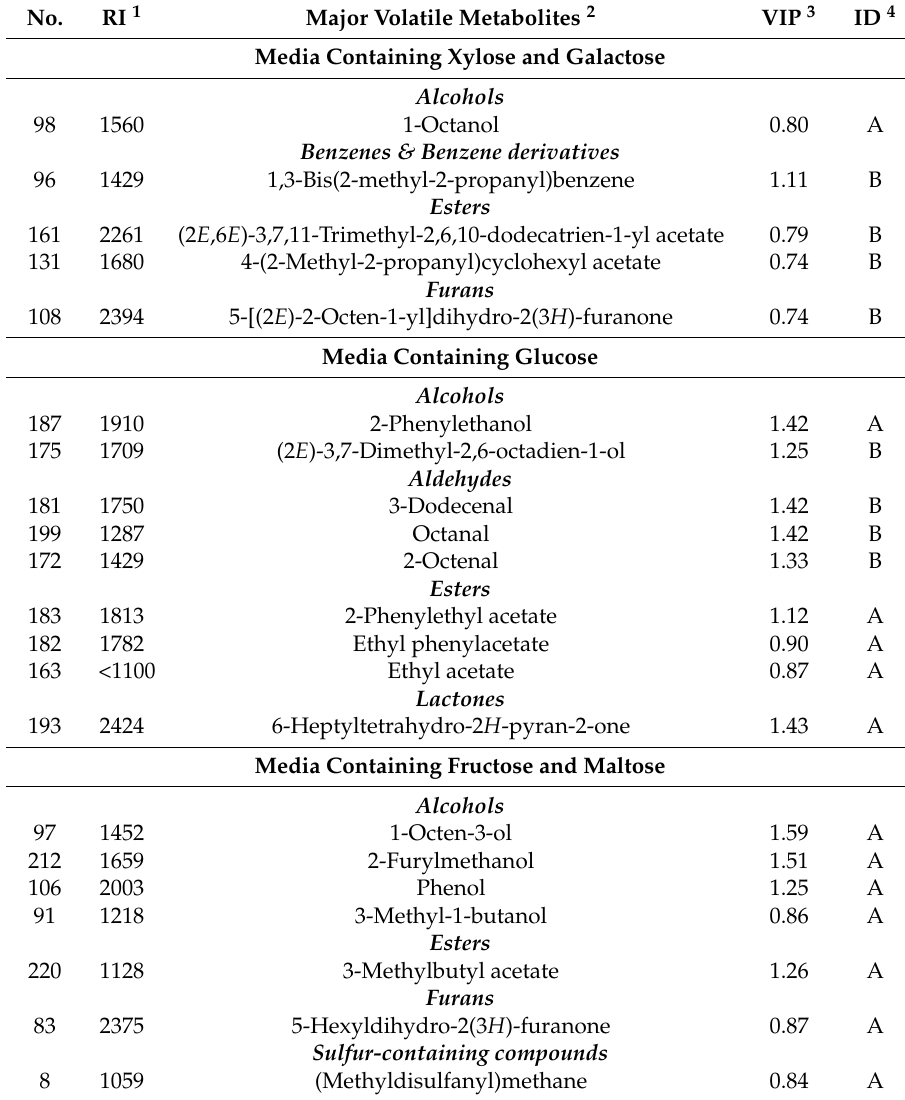
Table 1. The major volatile metabolites identified in S. fibuligera KJJ81 samples cultivated in media containing different